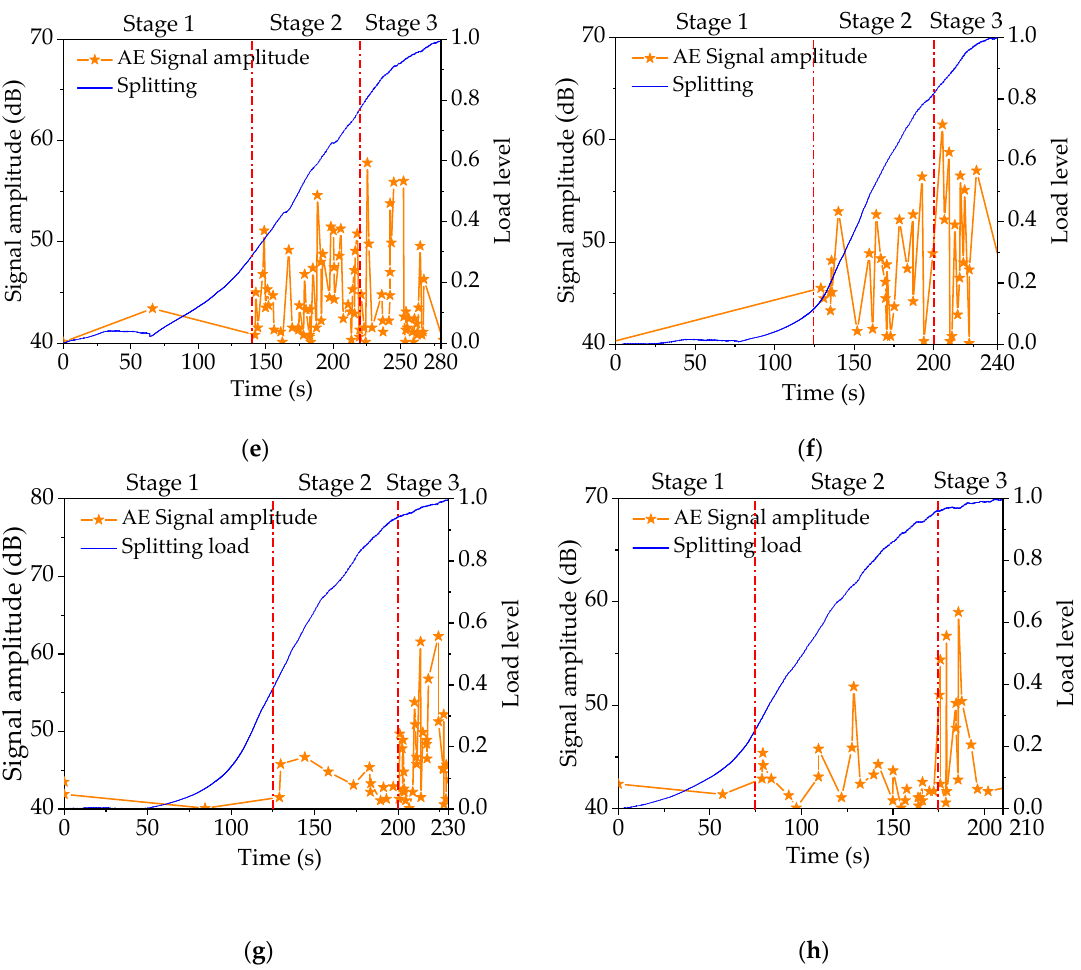
Figure 8. The AE amplitude and load level versus time during splitting at -10 °C for SBS-modified asphalt mixture with basalt fiber under various F-T cycles. ( a ) 0 F-T cycle; ( b ) 3 F-T cycles; ( c ) 6 F-T cycles; ( d ) 9 F-T cycles; ( e ) 12 F-T cycles; ( f ) 15 F-T cycles; ( g ) 18 F-T cycles; and ( h ) 21 F-T cycles.